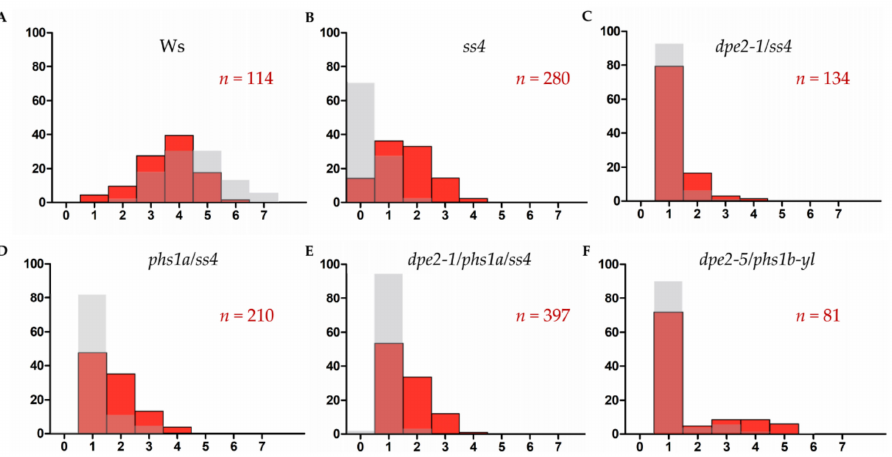
Figure 4. Distribution of the starch granule number per chloroplast. The quantity of the starch granules per chloroplast in the guard cells (red) was determined and compared with that of the mesophyll cells (grey). yl, young leaf. A – F indicate the data from wild type and corresponding mutants,